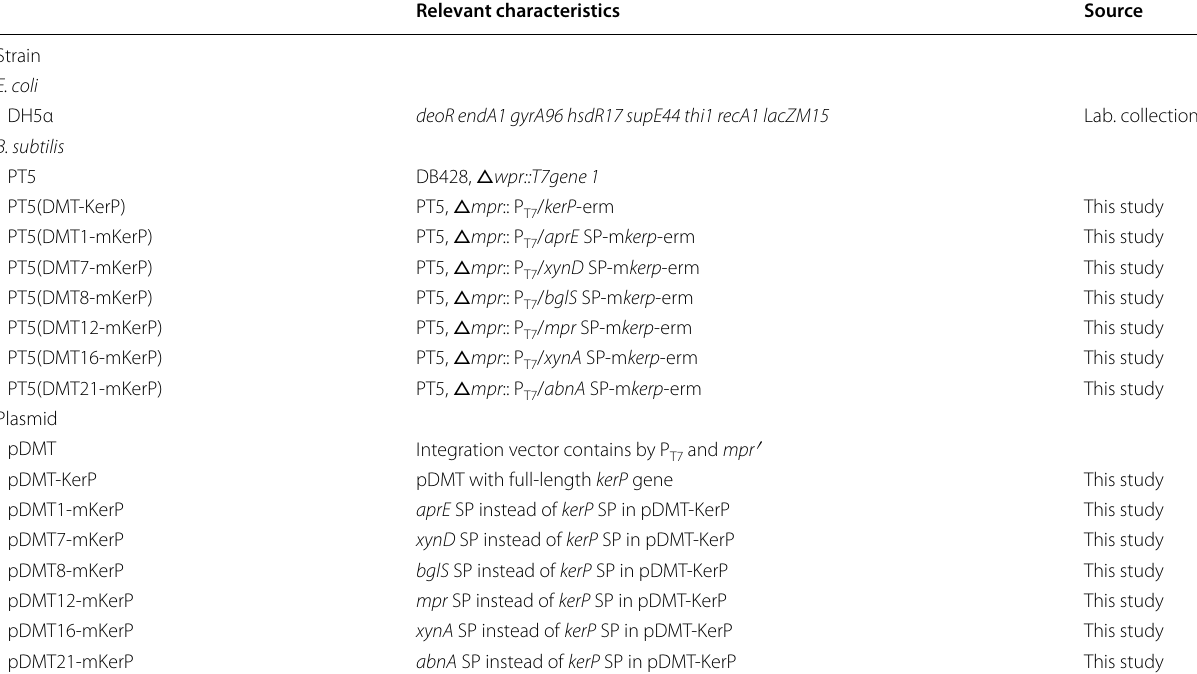
Table 1 Strains and plasmids used in this